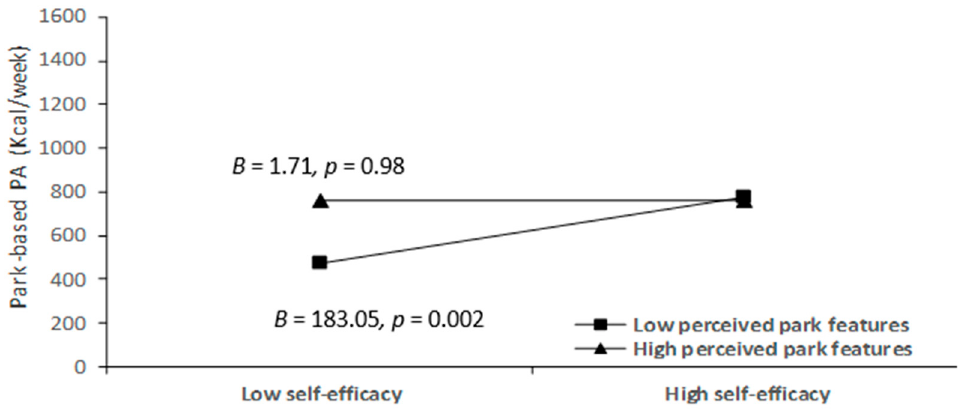
Figure 1. The interaction between perceived park features and self-e ffi cacy in the association with park-based physical activity among Leipzig older